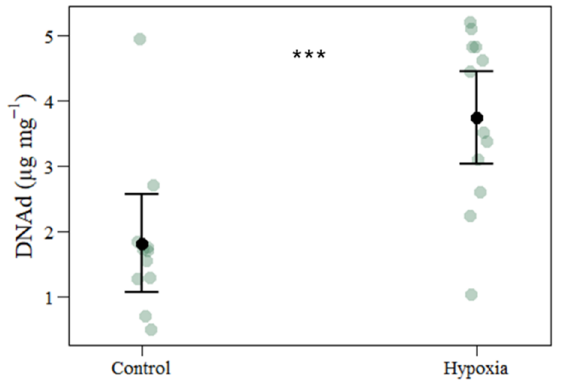
Figure 4. Oxidative DNA damage caused by ROS of coral fragments exposed to control and hypoxic treatments. The values represent mean and standard deviation, asterisks indicate significant differ- ences between the treatment groups at: p < 0.001 (***) (control n = 12; hypoxia n = 12). The n denotes the number of coral samples assessed in the analysis. Abbreviations: µ g: microgram; mg: milligram. CI from the model and each measurement point are represented.